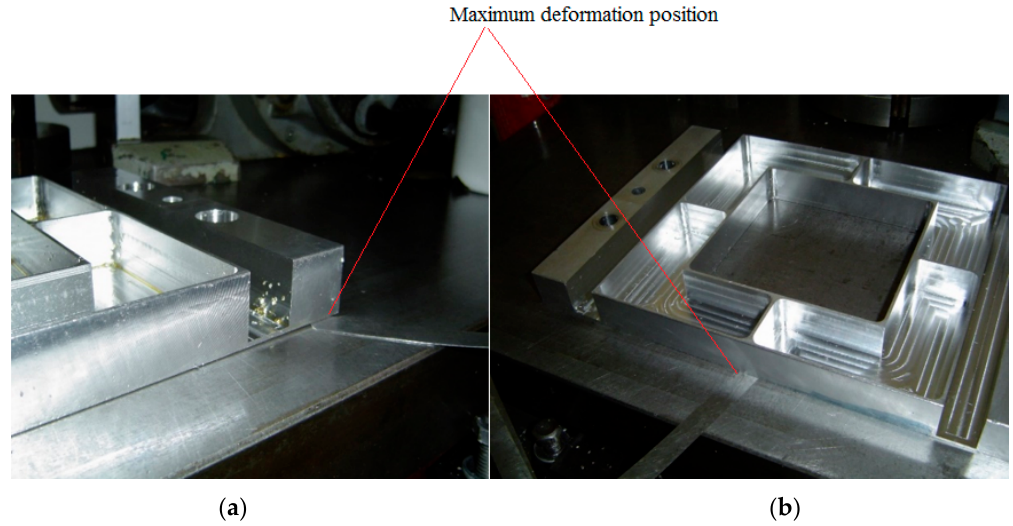
Figure 7. Stalloy insert into the maximum deformation place of ( a ) Specimen 1and ( b ) Specimen 2.